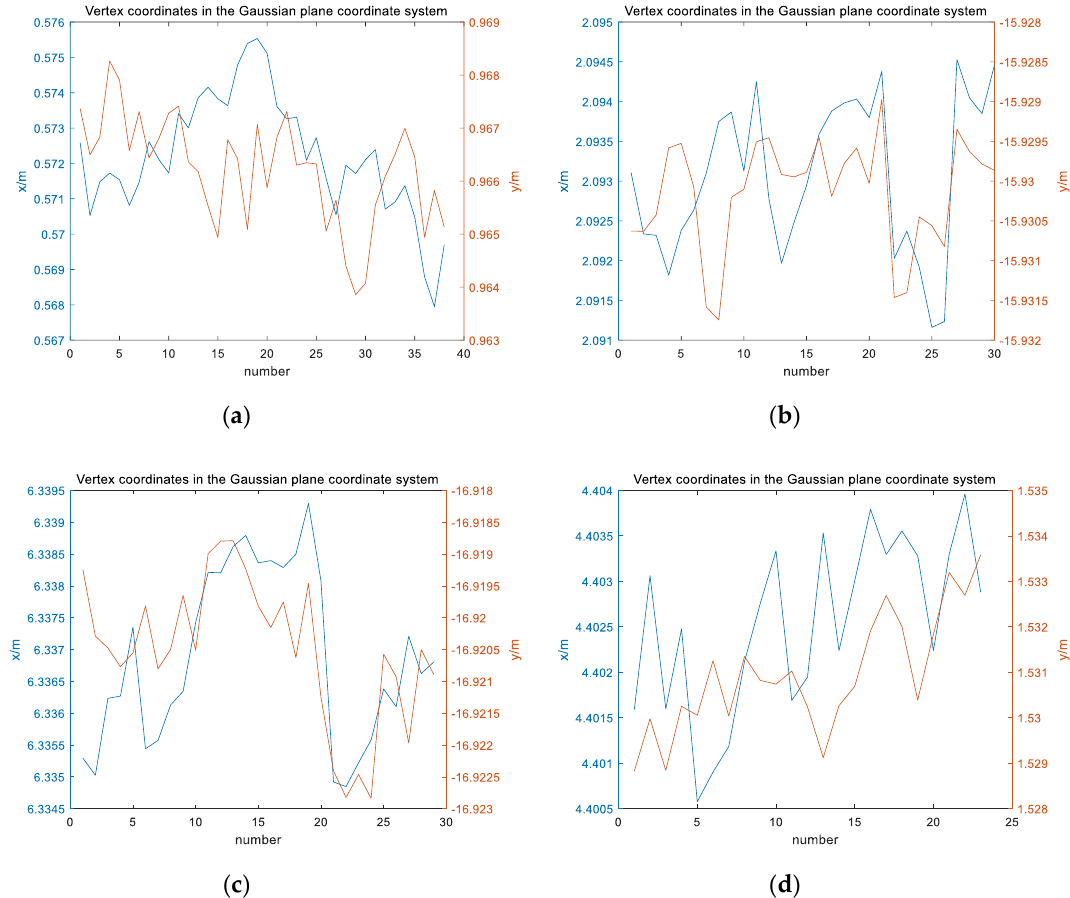
Figure 7. Four vertex coordinates in the Gaussian plane coordinate system respectively, where the horizontal axis represents the number of data ( a )38, ( b )30, ( c )29, ( d )23, the left vertical axis represents the x-axis in meters and the right vertical axis represents the y-axis in meters.